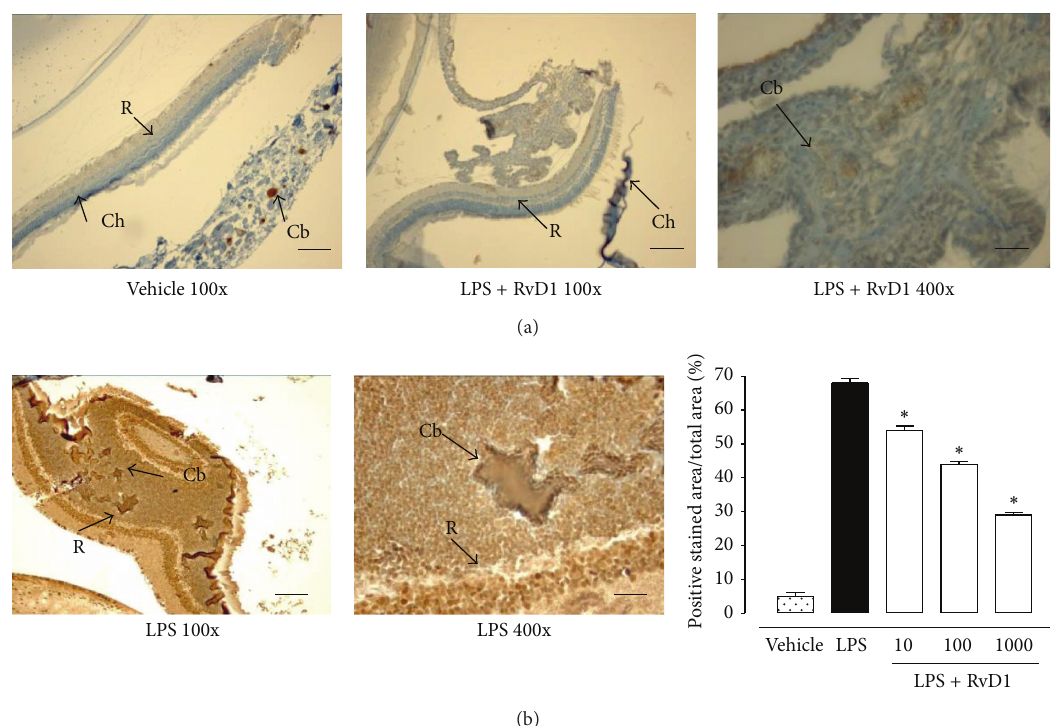
Figure 7: Resolvin (RvD1) and ubiquitin. (a) Sections showing representative immunohistochemistry for ubiquitin in the ocular tissues of rats treated with vehicle (saline+ethanol), LPS (200 𝜇 g/rat), or resolvin D1 at the lowest dose (10ng/kg, 1h post-LPS). (b) Graph showing the percentage of positive stained area for ubiquitin per total area analyzed at 400x magnification. Values are mean ± SEM of 𝑛 = 6 observations for group. ∗ 𝑃 < 0.01 versus LPS-treated rats. R = retina; S = sclera; Cb = ciliary bodies; Ch =